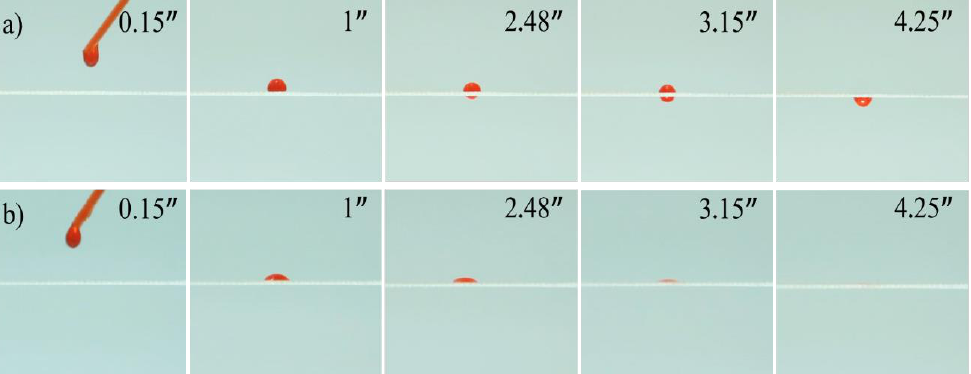
Figure 2. Still frames taken from digital videos to show dropping red-dyed water on the one-side electro-sprayed polyester fabric, ( a ) on the SU-8 sprayed surface; ( b ) on the unsprayed back surface.